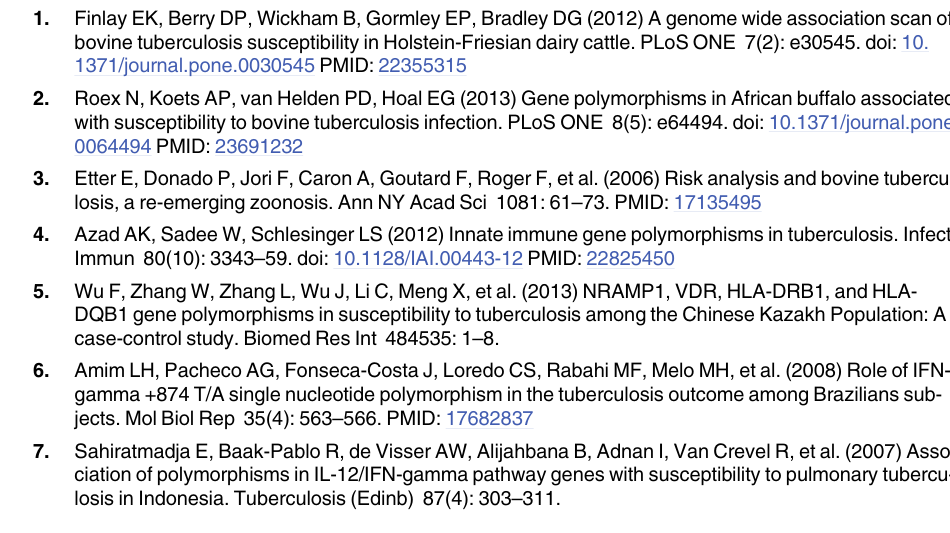
S1 Fig. Linkage disequilibrium analysis of SNPs in the CARD15 gene. S1 Table. Primers of the CARD15 gene